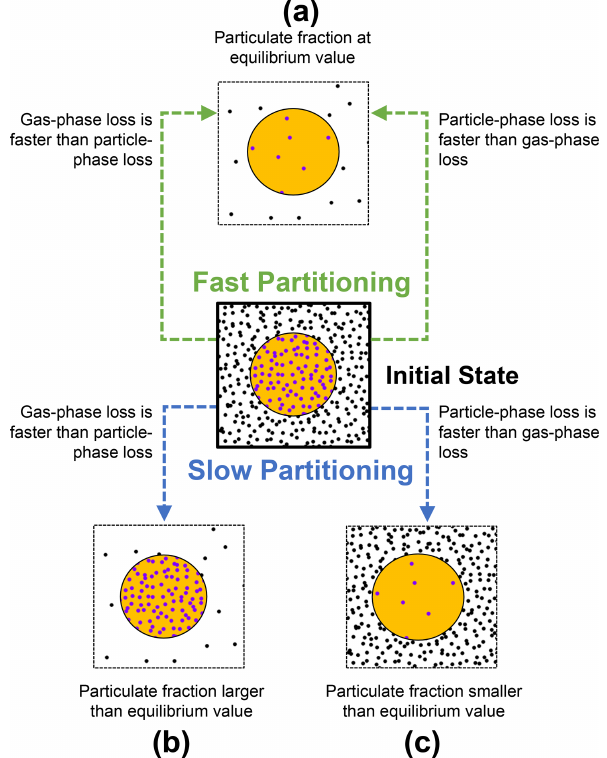
Figure 2. Schematic on how the gas–particle partitioning equilib- rium of a semi-volatile compound may be perturbed from an ini- tial state (center) due to chemical loss, depending on equilibration timescales. If the timescales of partitioning are shorter than the timescales of chemical loss, the system is able to maintain equi- librium (a) . However, the combination of rapid gas-phase loss and slow replenishment from the particle phase increases the particulate fraction above the equilibrium value (b) . In turn, the combination of rapid particle-phase loss and slow replenishment by condensa- tion decreases particulate fraction below the equilibrium value (c)